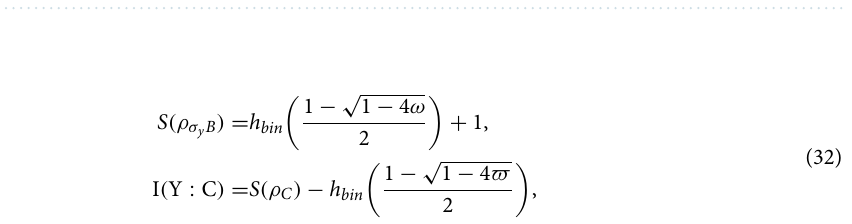
Figure 3. (Color online) Time evolutions of U (red line), U M (purple line), U D (black dashed), π ABC (gray line), N AB (blue line), N BC (green line), and N AC (orange line) under the measurement ( σ x , σ z ). ( a ) γ = 0.1, B = 0, ( b ) γ = 0.1, B = 2, and ( c ) γ = 0.5, B = 0, and ( d ) γ = 0.5, B = 2. All Figs. J z =